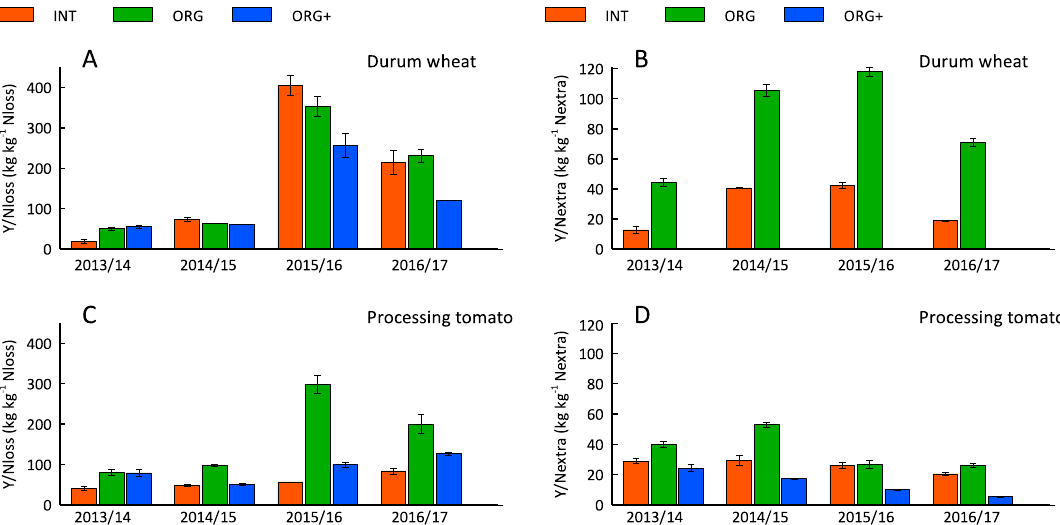
Figure 3. Yield per unit of N leached (Y / Nloss, kg kg − 1 N), yield per unit of extra-farm N (Y / Nloss, kg kg − 1 N) in durum wheat (top: ( A ) and ( B ), respectively) and processing tomato (bottom: ( C ) and ( D ), respectively) in the three cropping systems: integrated (INT), traditional organic (ORG) and innovative organic (ORG + ). Bars represent the standard errors.